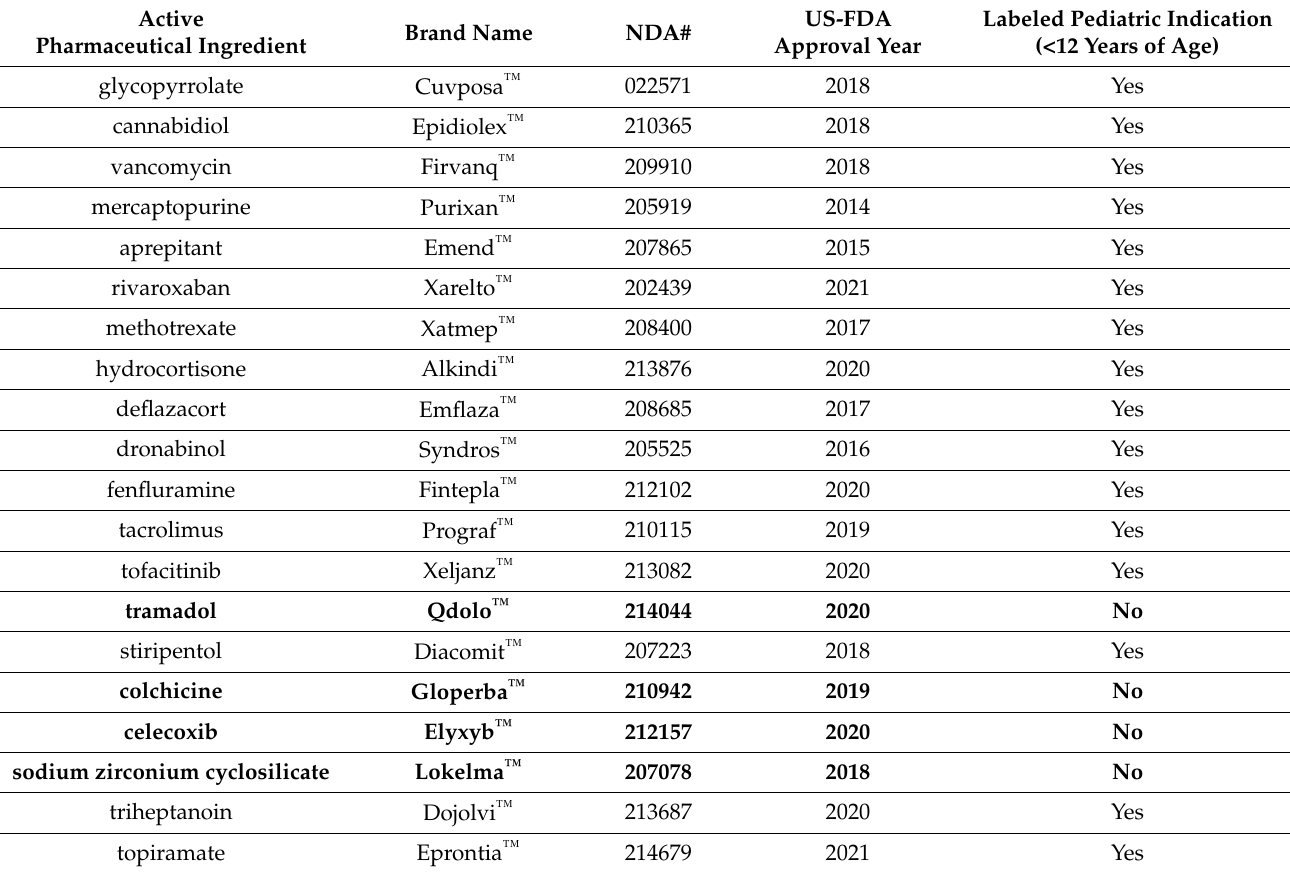
Table 3. FDA-approved and marketed in finished oral liquid or granule dosage forms—2014 to